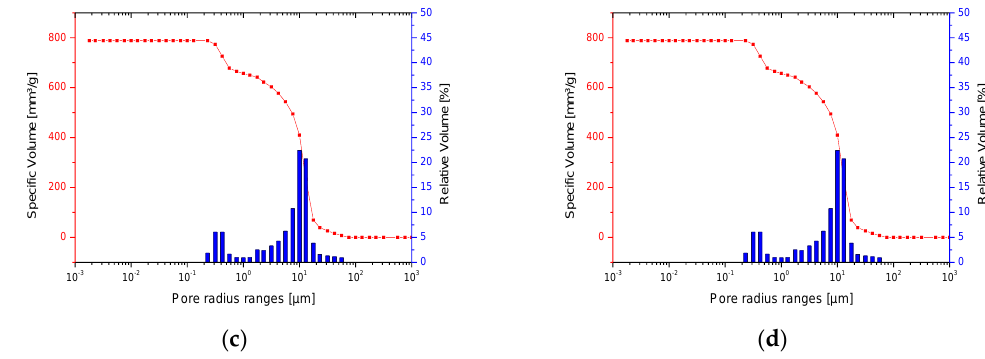
Figure 5. Pore size distribution: ( a ) pure BG; ( b ) pure β-TCP; ( c ) 50/50; and ( d ) 70/30. Because of the different particle sizes and milling grades of the used granules, different pore size distributions can be observed. Table 4. Mercury Porosimetry parameters for the scaffolds ( n = 3).